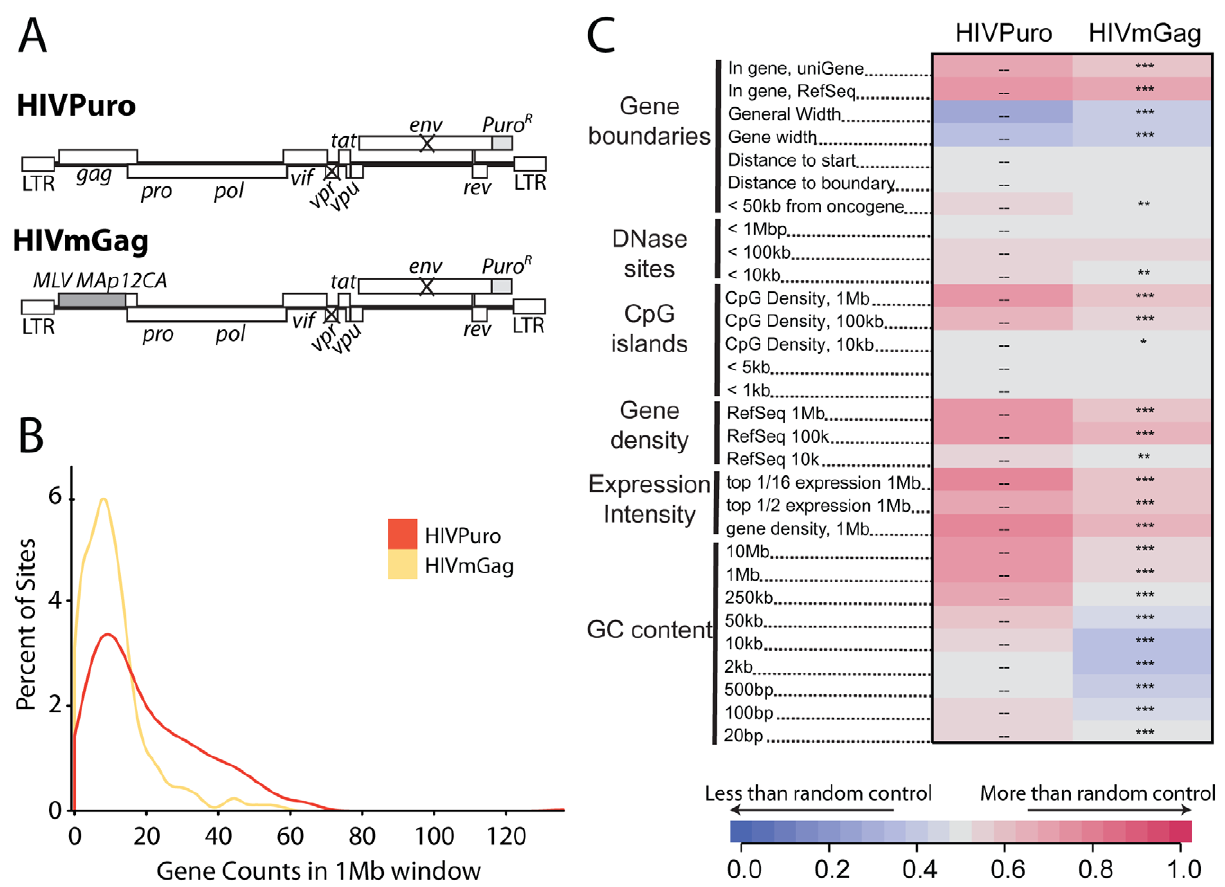
Figure 7. A chimeric derivative of HIV containing MLV gag (HIVmGag) shows reduced integration frequency in gene dense regions. (A) Genetic map of HIV proviruses containing wild type gag (HIVPuro) or a chimera encoding MLV Gag (MA, p12, and CA) in place of HIV MA and CA (HIVmGag). Both viruses have inactivated vpr and env and a puromycin selectable marker in place of nef . (B) Histogram indicating distribution of HIVPuro and HIVmGag integration sites with respect to gene density measured in 1 Mb intervals surrounding integration events. Data is plotted as in Fig. 1C and curves are computed using Gaussian kernel density estimates. (C) Genomic heatmap of HIVPuro and HIVmGag datasets. Significant differences are shown by asterisks (*p , 0.05; **p , 0.01; ***p , 0.001). Annotations at the left of the heat map are as in Figure 2 and described in Text S1. An interactive version of this figure is available as Figure S8.